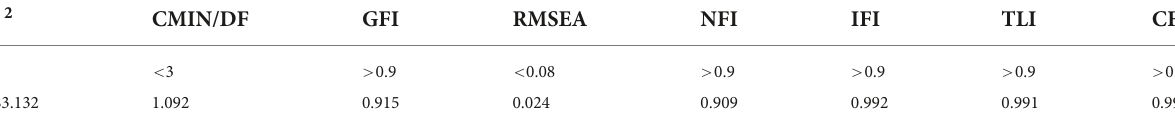
TABLE 6 Goodness-of-fit indices of the structural